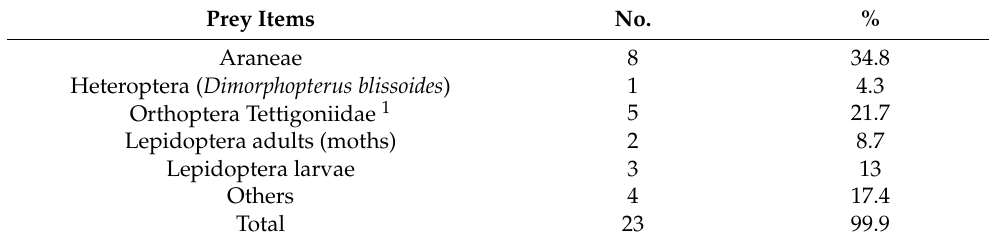
Table 4. Number of prey items identified by visual analysis of three hours of video recordings of three Reed Warbler pairs provisioning cuckoo chicks at their parasitized nest in Mirandola in June 2018. Prey Items No. %